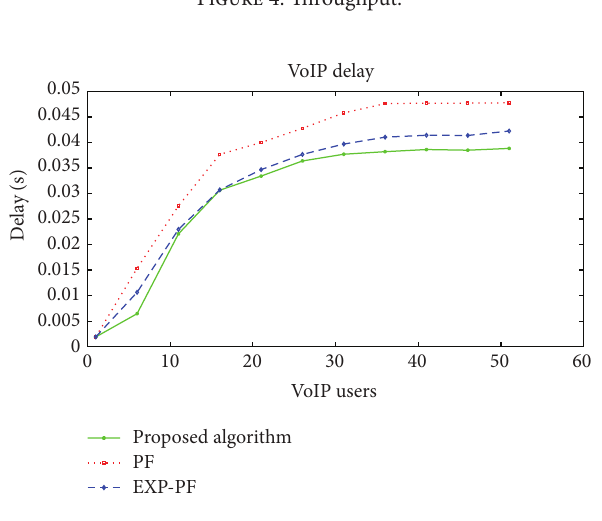
Figure 4: Throughput.